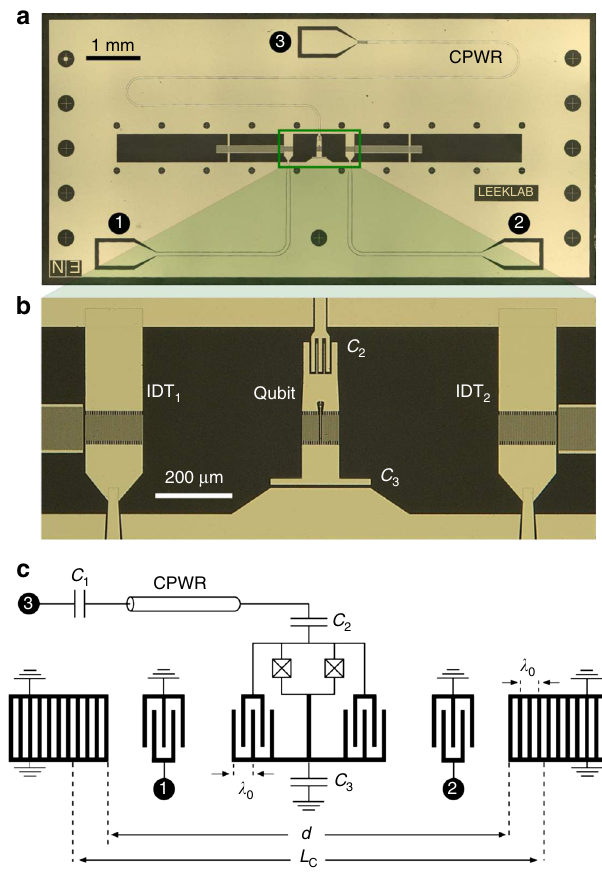
Fig. 1 Circuit quantum acoustodynamics device. a Optical image of the measured device. In the centre of the chip, a transmon is embedded in a SAW cavity. A coplanar waveguide resonator (CPWR) is coupled to the transmon and measured via port 3. The SAW cavity is probed via two interdigitated transducers (IDTs) connected to ports 1 and 2. b Close-up image showing the transmon qubit and SAW IDTs in between the two Bragg gratings that form the SAW cavity. c Equivalent electrical circuit of the device incorporating a spatial schematic of the SAW cavity. The geometrical parameters λ 0 , d and L c denote the wavelength, the distance between the two Bragg gratings and the effective length of the cavity,